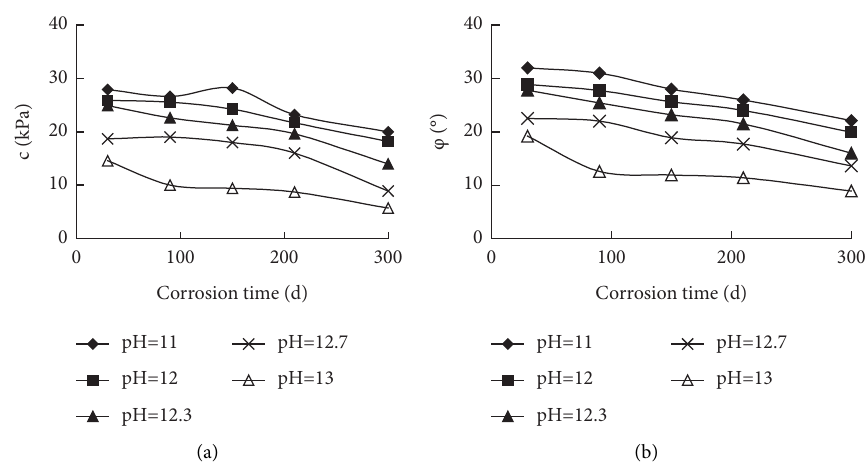
Figure 2: Variation patterns of the strength parameters with the permeation time at different alkaline-solution concentrations. (a) c and (b) φ .